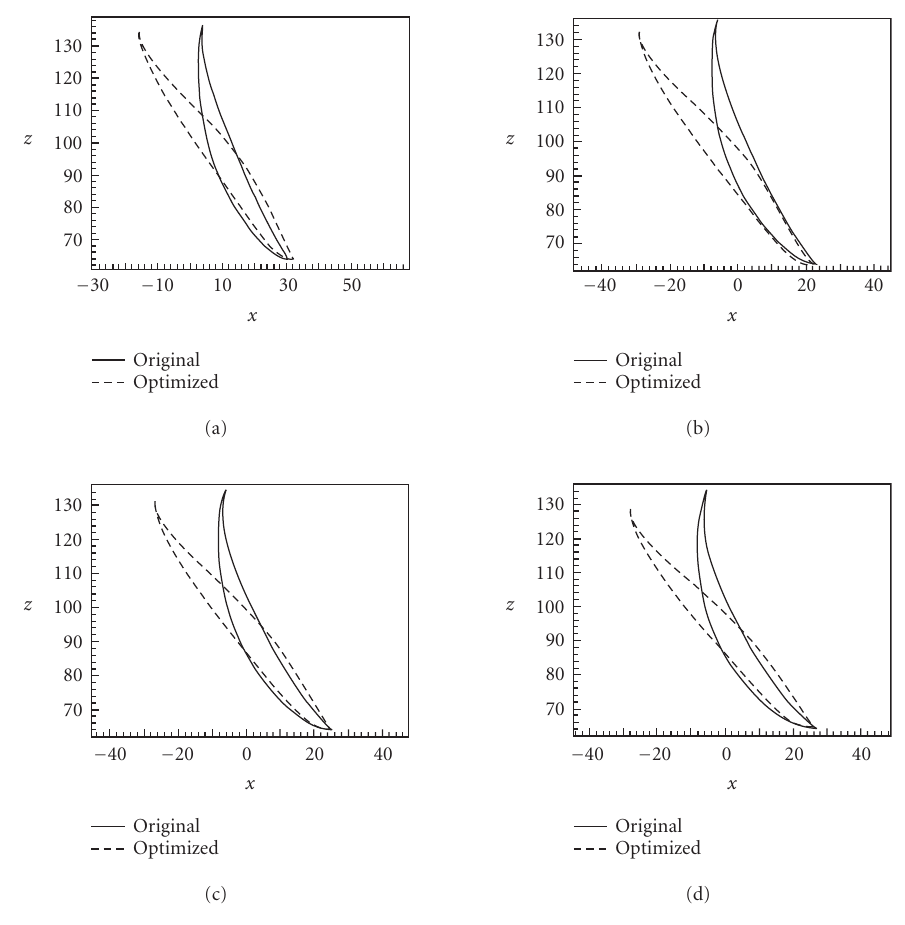
Figure 7: Comparison between the original stator blade profile and the optimized one: (a) section 1, (b) section 2, (c) section 3, and (d) section